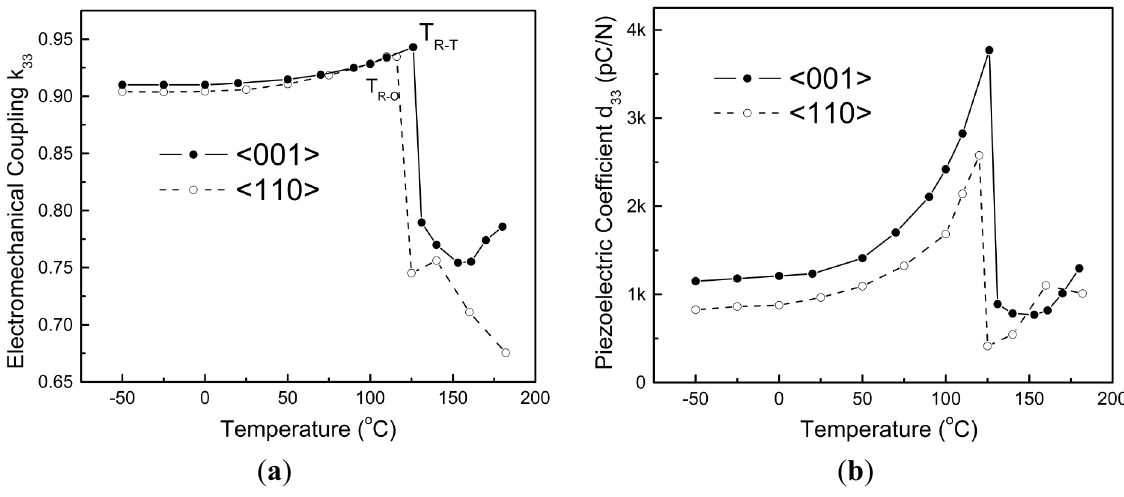
Figure 6. Longitudinal electromechanical coupling k ( b ) as a function of temperature for <001>- and <110>-poled single crystals. Reprinted with permission from [69]. Copyright 2009 AIP Publishing.